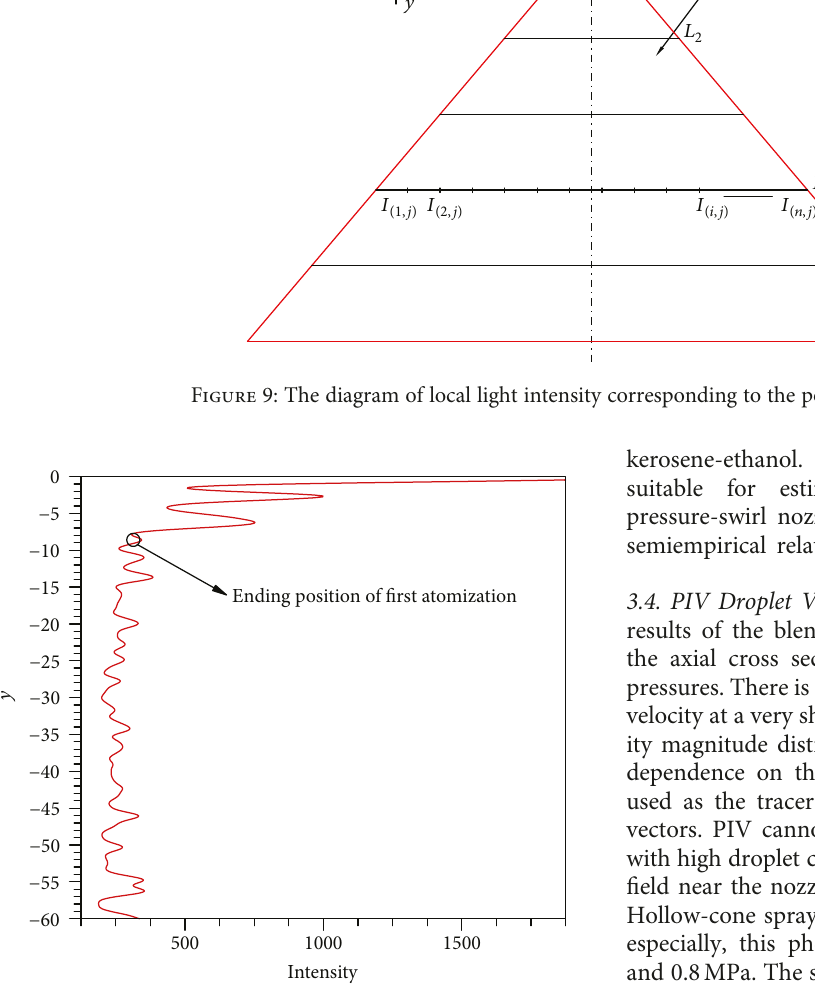
y ) varies along the axial